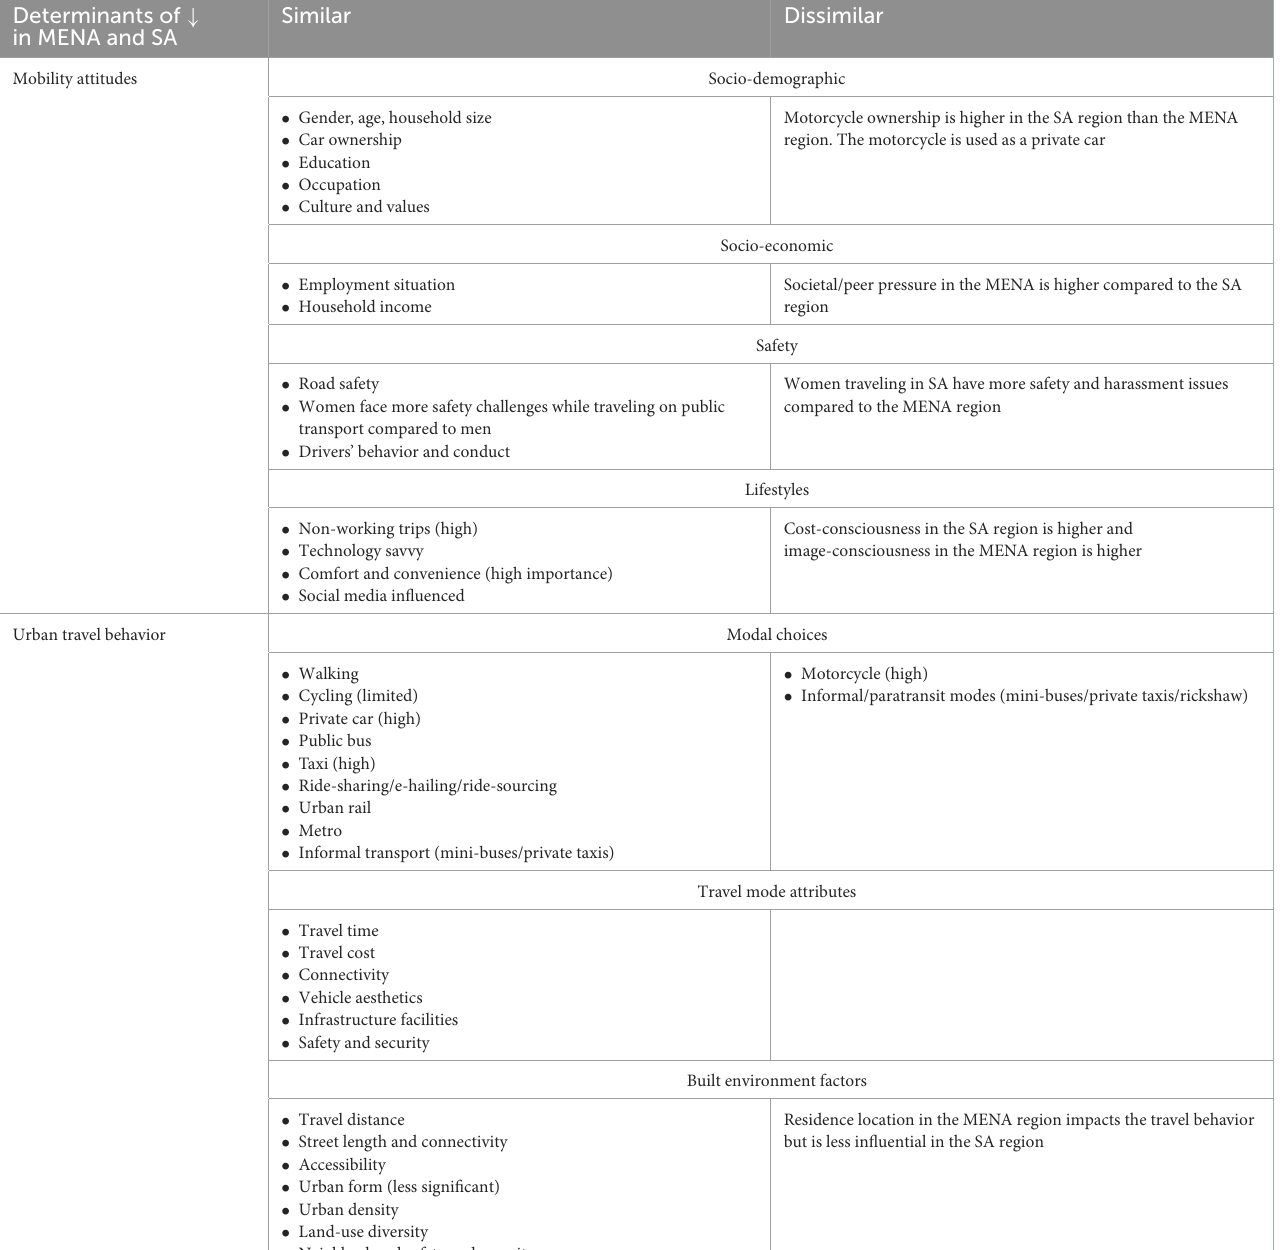
TABLE 1 Key determinants of mobility attitudes and travel behaviors among MENA and SA cities. Determinants of ↓ in MENA and